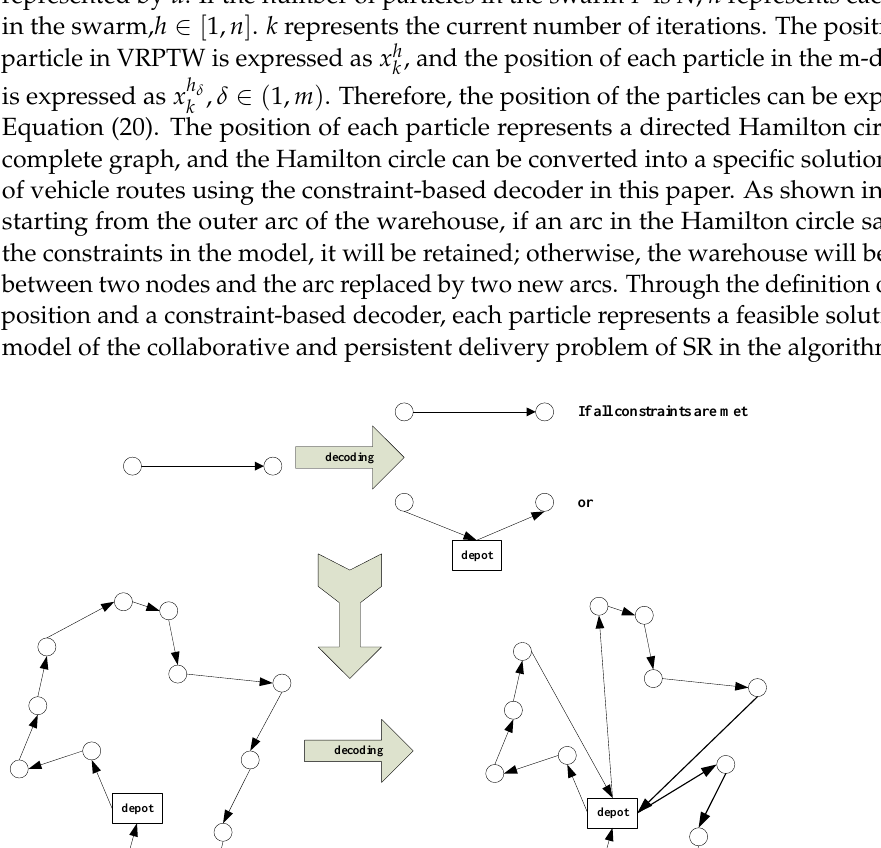
the m-dimensional space is defined in Equation